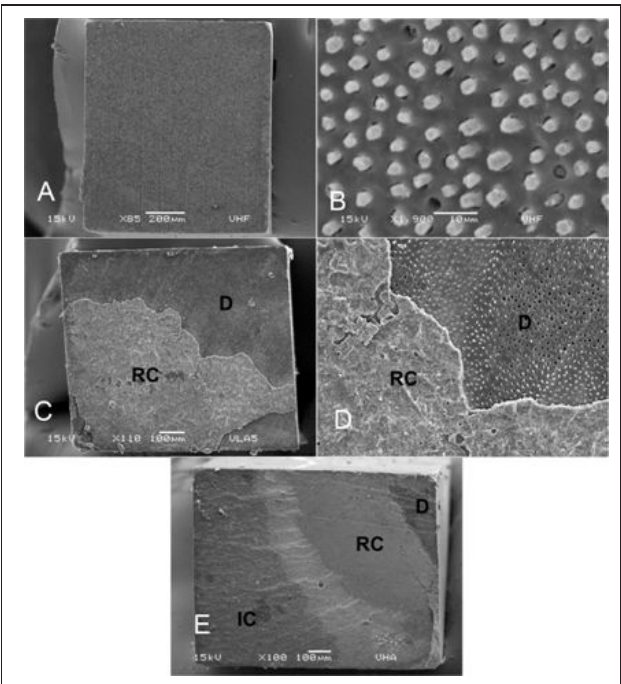
Fig. 2. (A) Fractured end of specimen cemented with Variolink II (high viscosity and dual-cure) exhibiting adhesive failure along dentin surface (original magnification X85). (B) Higher magnification of Figure 2A revealing fractures located predominantly within the hybrid layer and resin tags inside the dentinal tubules (original magnification X1900). (C) Fractured end of specimen cemented with Variolink II (low viscosity and self-cure) exhibiting mixed failure mode, characterized by adhesive and cohesive failures within the resin cement (original magnification X100). D- dentin; RC- resin cement. (D) Higher magnification (X500) of Figure 2C demonstrating RC (resin cement) and D (dentin) within same fractured surface. (E) Fractured end of specimen cemented with Variolink II (high viscosity and self-cure) exhibiting mixed failure mode, characterized by adhesive and cohesive failures within the resin cement and within indirect composite (original magnification X100). D- dentin; RC- resin cement; ID- indirect